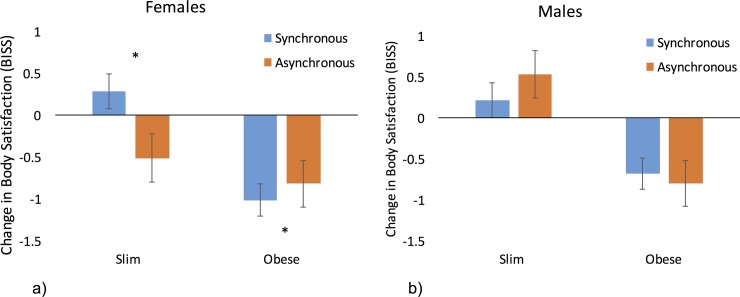
Body size x synchrony x sex interaction.Changes in explicit body satisfaction following synchronous and asynchronous touch applied to both obese and slim bodies for females (a) and males (b). Females demonstrate increased body satisfaction when synchronous touch is applied to a slim body compared to the asynchronous control condition. Relative decreases in body satisfaction were reported for synchronous compared to asynchronous touch applied to an obese body. Males show increases in body satisfaction for a slim body and decreases for an obese body irrespective of touch. Bars represent mean scores and error bars depict standard error. * = p < .05.